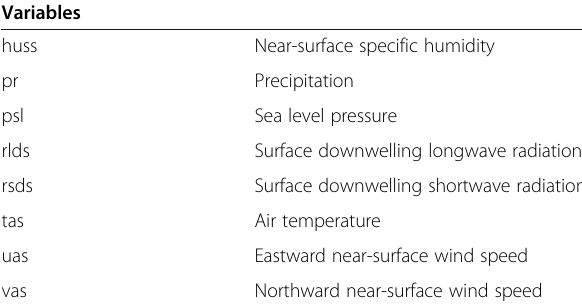
Table 2 Atmospheric variables used for constructing the model forcing from CMIP5 (MIROC5 and MRI-CGCM3)